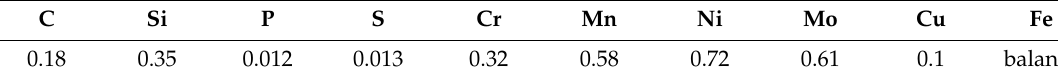
Table 1. Chemical composition of 18MND5 steel (wt%).